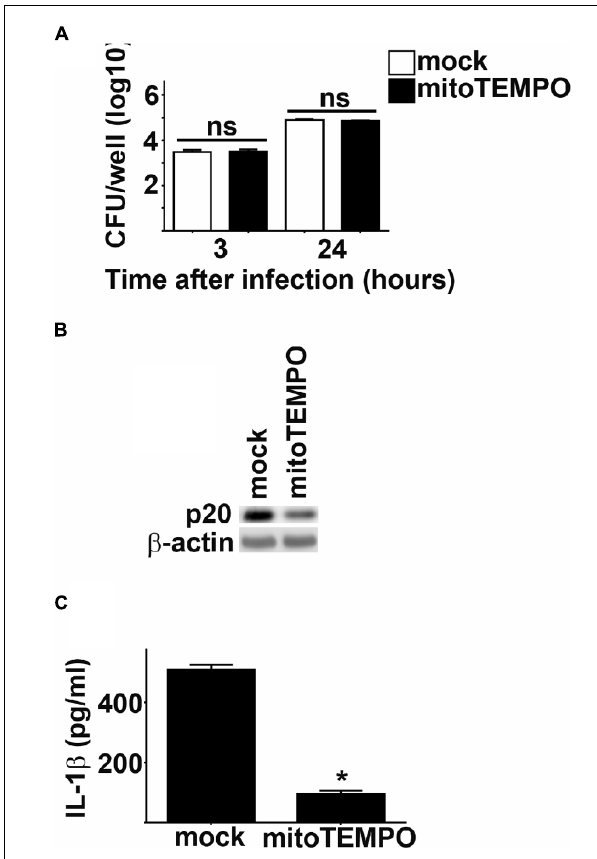
FIGURE 5 | mROS potentiates Fn mediated inflammasome activation. BMM were treated with mitoTEMPO or DMSO (vehicle control; mock) 1 h prior to infection with Fn MOI 250. (A) Intracellular bacteria were enumerated at the indicated times after infection. ns, not significant. (B) Western blots of cell lysates were probed for caspase-1 p20 and actin. (C) Culture supernatants were assessed for IL-1 by ELISA. Error bars depict SD. ns, no significant difference between mock treated cells. * p < 0.05 compared all mock treated cells. Data are representative of